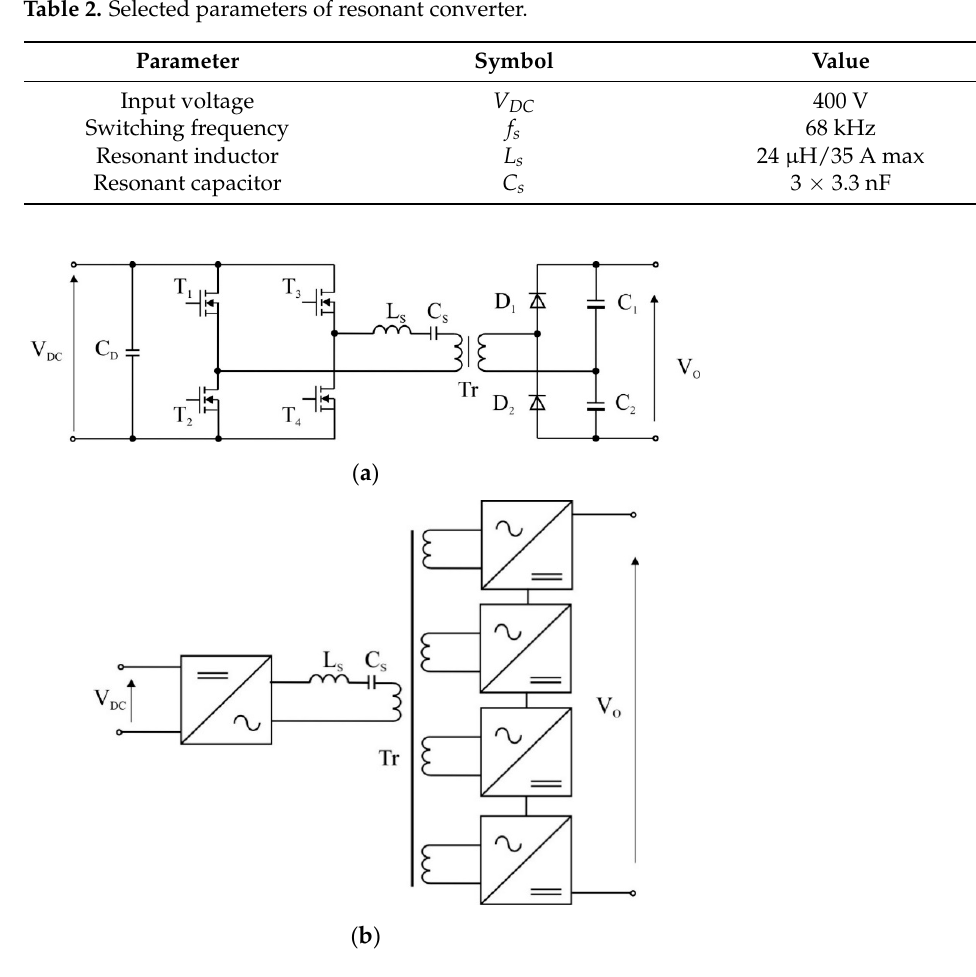
Figure 5. Scheme of the single resonant converter module ( a ) and complete schematic with four rectifiers ( b ).